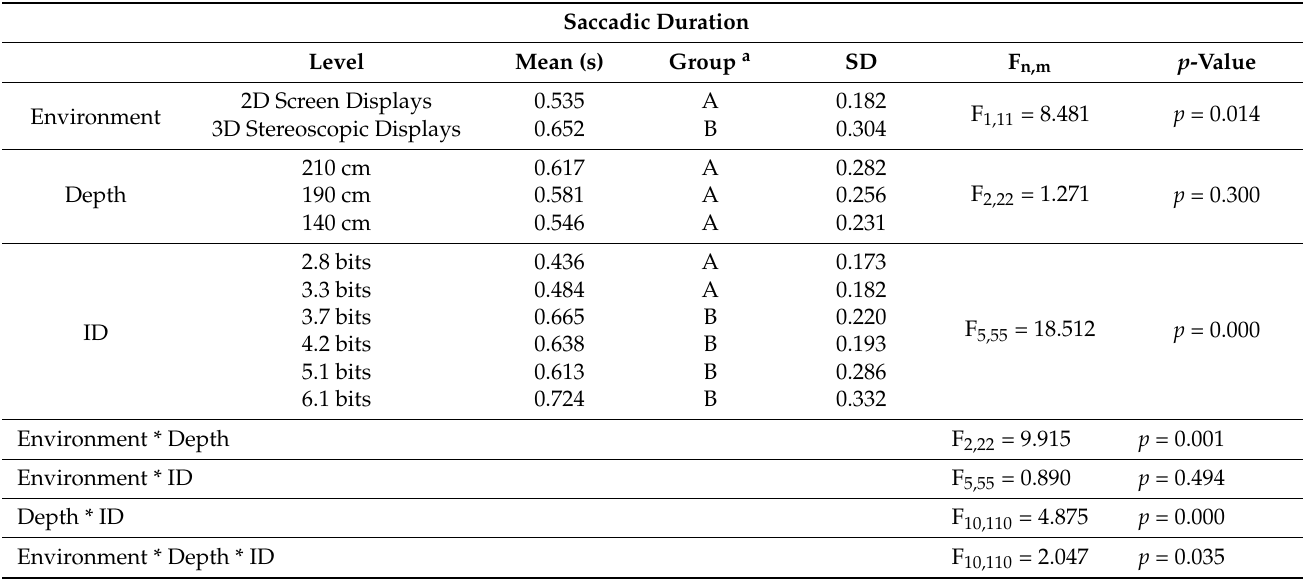
Table 7. Means, SDs, ANOVA, and Tukey HSD test results of saccadic